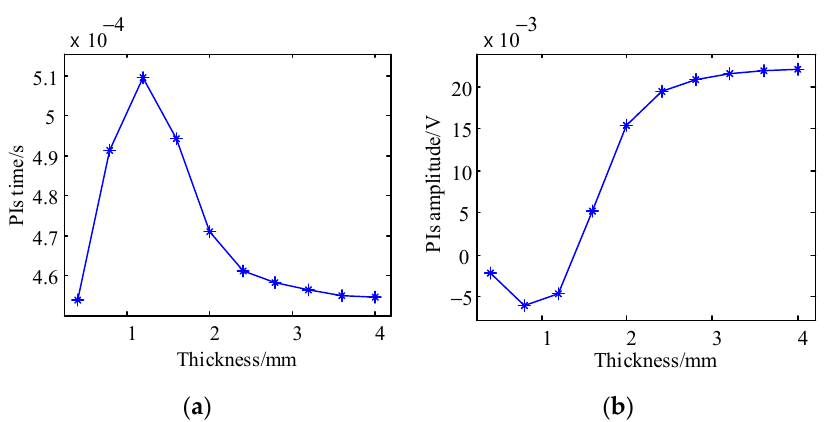
Figure 11. PIs amplitude change with thickness and conductivity.